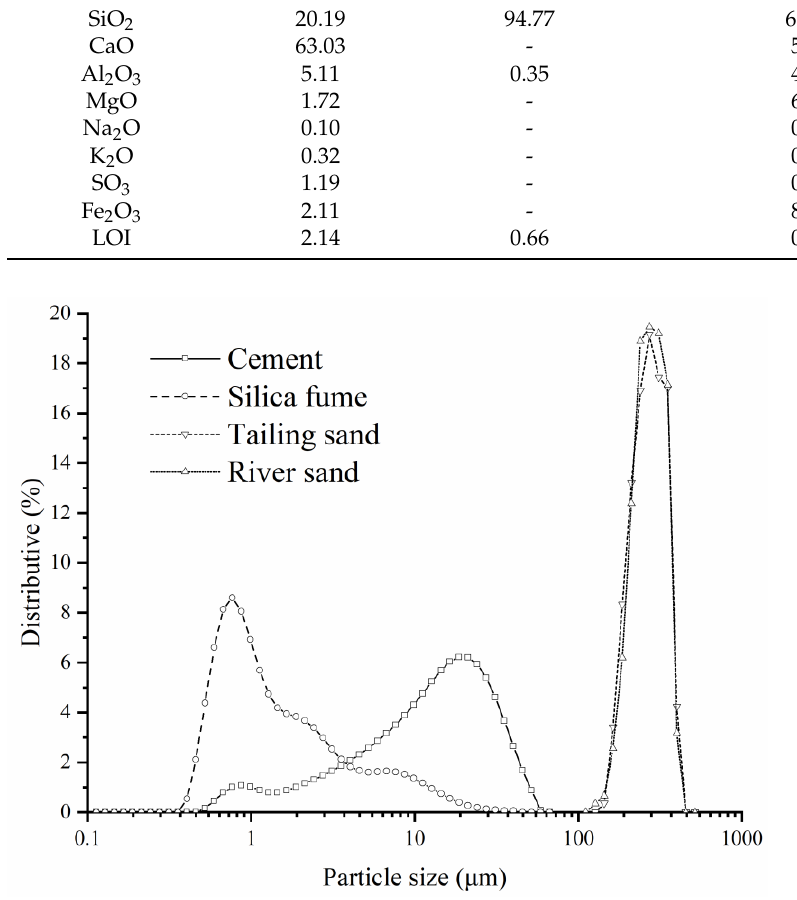
Figure 1. Particle size distribution of binders used in this study. Table 1. Chemical analysis of the cementitious materials and iron tailings (%).